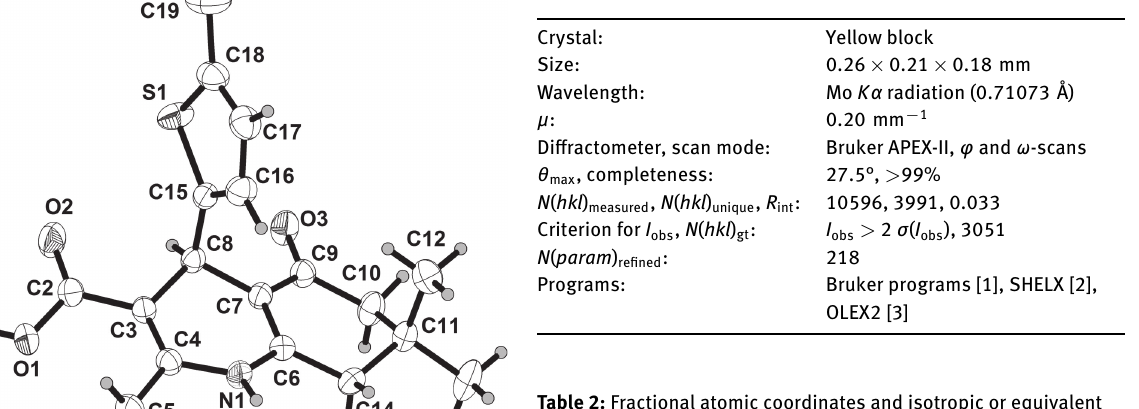
Table 2: Fractional atomic coordinates and isotropic or equivalent isotropic displacement parameters (Å 2